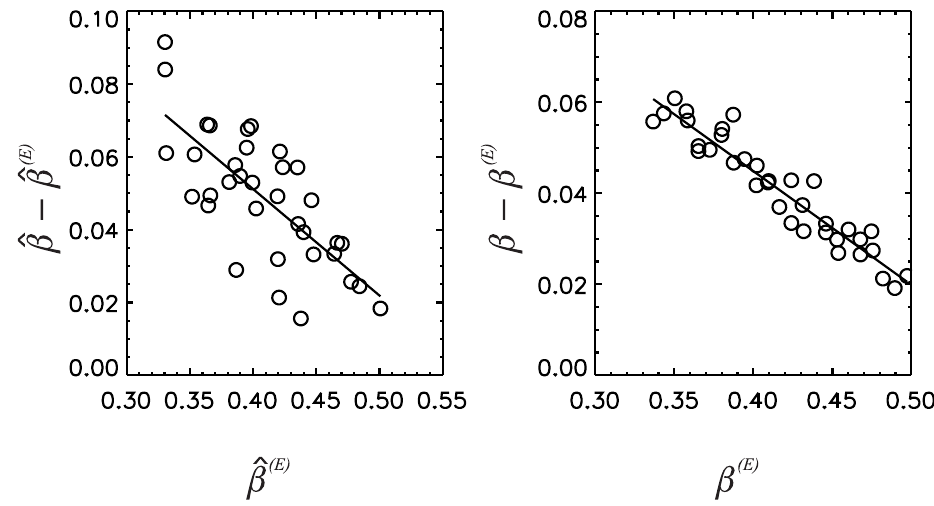
Fig. 16. (a) Difference ˆ β − ˆ β (E) as a function of ˆ β (E) and (b) difference ˆ β − β (E) as a function of β (E)